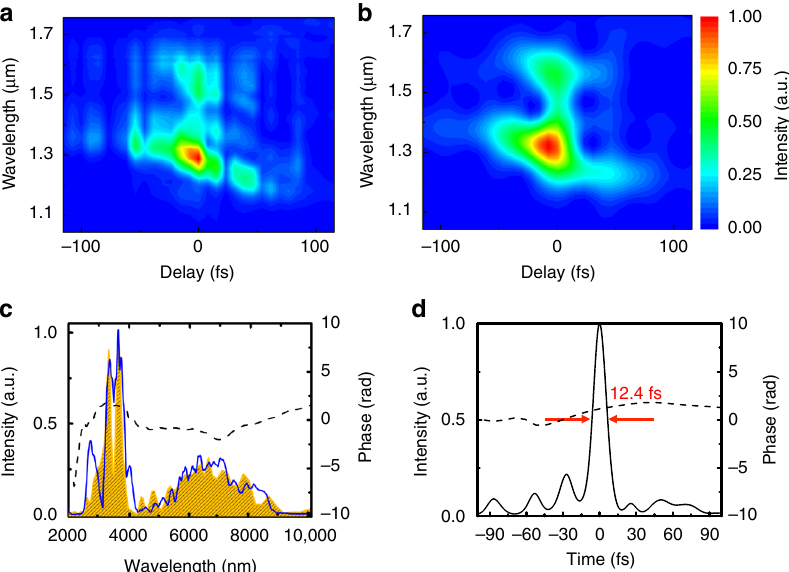
Fig. 5 Temporal characterisation of the synthesised mid-infrared pulse. The measured ( a ) and the retrieved ( b ) cross-correlation frequency-resolved optical gating (XFROG) traces. The FROG error is 1.8%. The retrieved spectral ( c ) and temporal ( d ) intensity pro fi les of the synthesised pulse. The dotted curves are the retrieved phase. Pulse width (12.4 fs) in full-width at half maximum is measured with a centre wavelength at 4.2 µ m. It corresponds to 0.88 optical